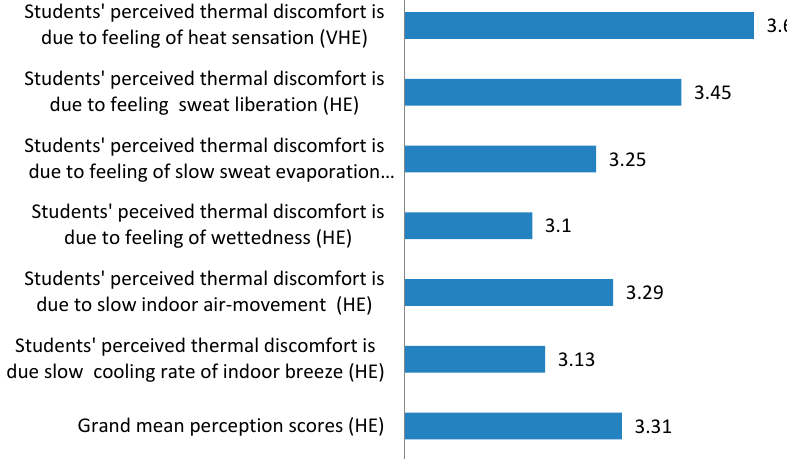
Figure 3. Students’ perceived thermal discomfort levels in LTH-2. VHE: very high extent; HE: high extent; ME: moderate extent; LE: low extent.